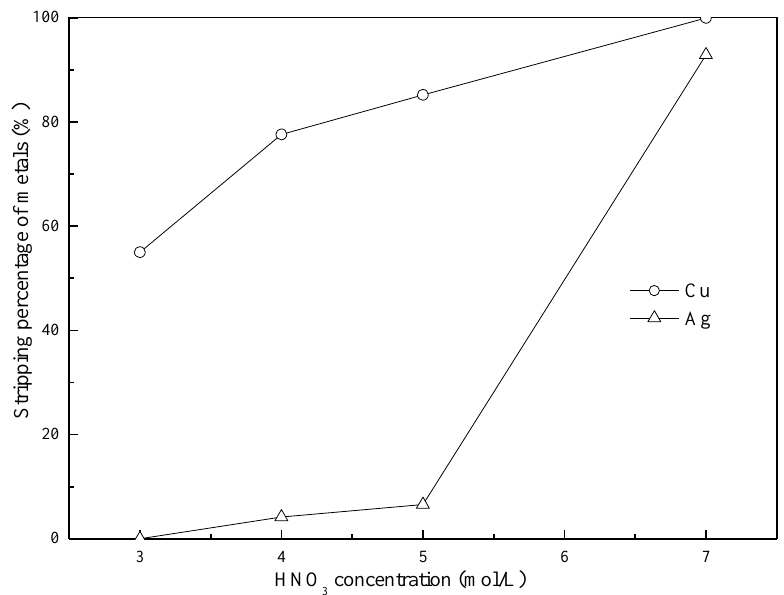
Figure 5. Stripping percentages of Cu(II) and Ag(I) at various HNO 3 concentrations.